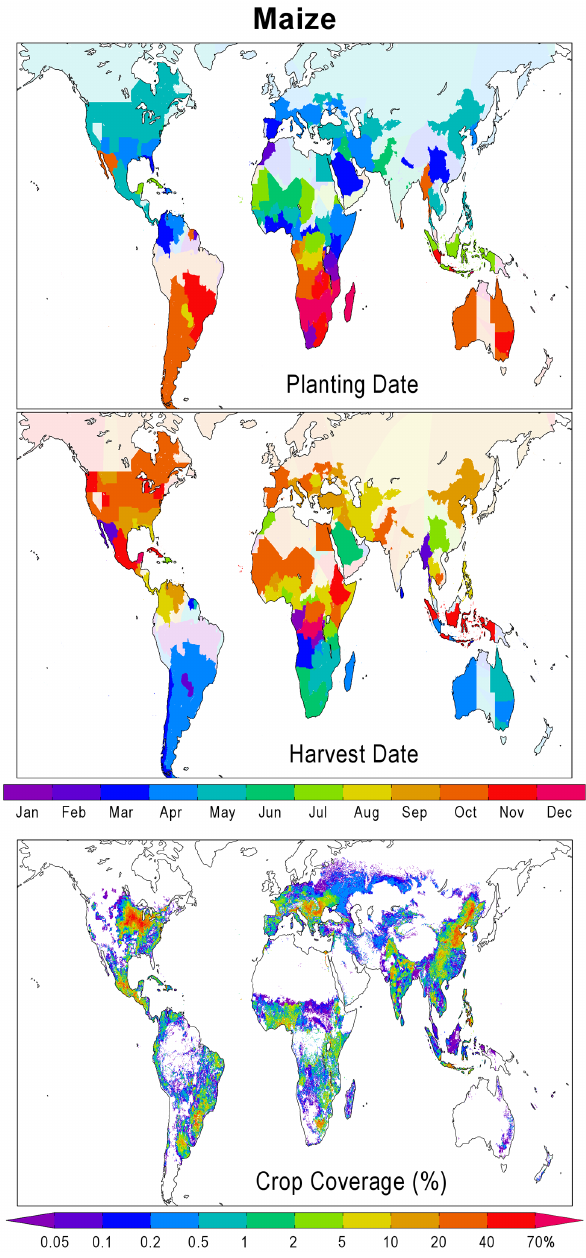
Figure 6. Mean planting and harvest dates (indicated by month) and the fractional coverage of each 1/12 ◦ × 1/12 ◦ grid box of the crop maize, from the data of Sacks et al. (2010).